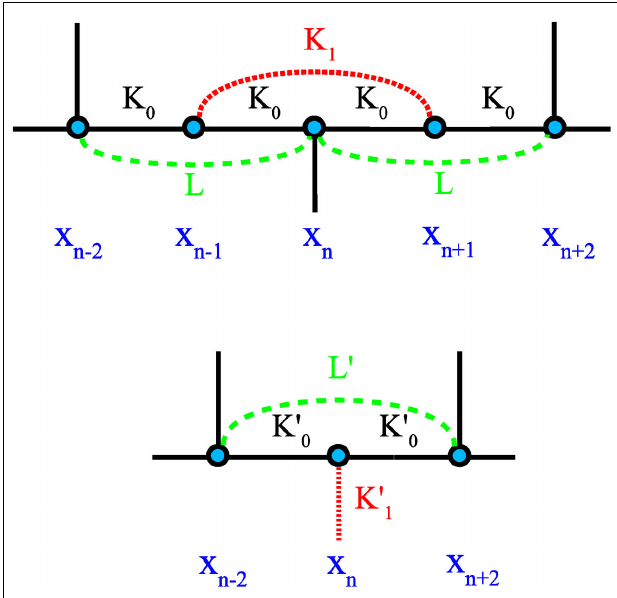
FIGURE 3 | Depiction of the (exact) RG step for the Ising model on HN3. The step consists of tracing out odd-labeled variables x n ± 1 in the top plot and expressing the renormalized couplings ( L (cid:9) , K (cid:9) terms of the old couplings ( L , K 0 , K 1 ). Note that the original network in Figure 1 does not contain couplings of type ( L , L (cid:9) ), but that they certainly become relevant during the